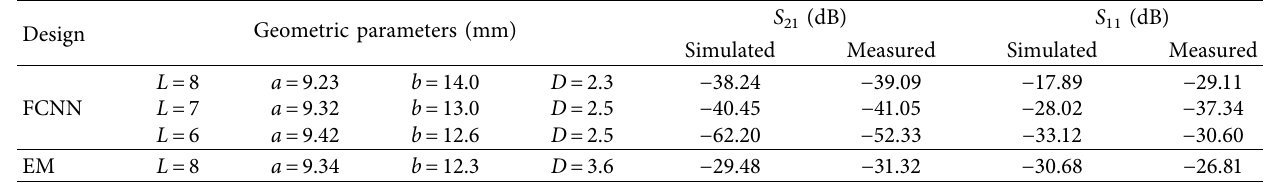
Figure 7: Comparison of predicted and simulated S -parameters response. (a) Refection | S Table 1: Comparison of simulated and measured results of the proposed arrays by diferent design methods.